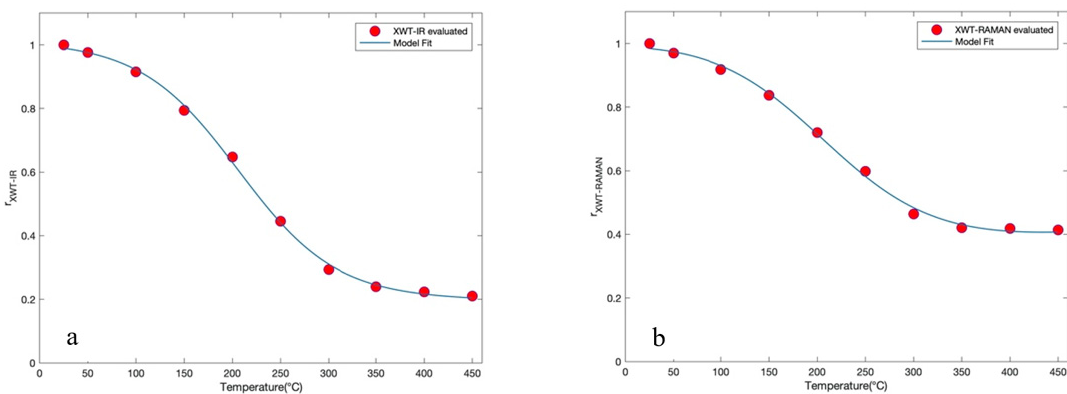
Figure 4. ( a ) Wavelet cross correlation (XWT) versus temperature for CNTs, for the recorded Raman spectra, together with the fit of the model (blue line) in the temperature interval (25–450 ◦ C); ( b ) XWT versus temperature for CNTs, for the recorded Raman spectra, together with the fit of the model (blue line) in the temperature interval (25–450 ◦